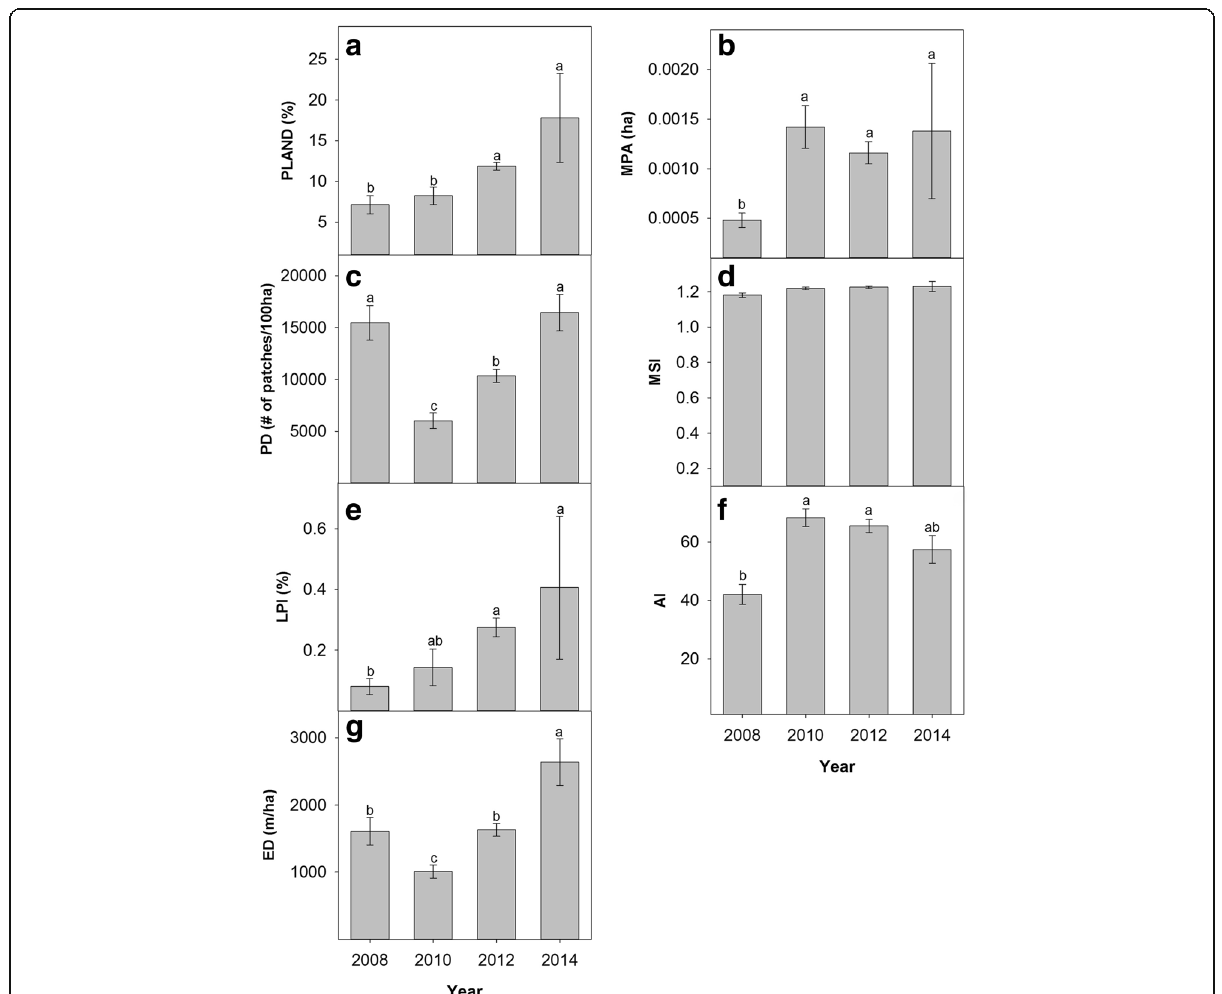
Fig. 4 Landscape metrics describing the spatial structure of tanglehead in the five study sites in South Texas: percentage cover ( a ), mean patch area ( b ), patch density ( c ), mean shape index ( d ), largest patch index ( e ), aggregation index ( f ), and edge density ( g ). Error bars represent standard